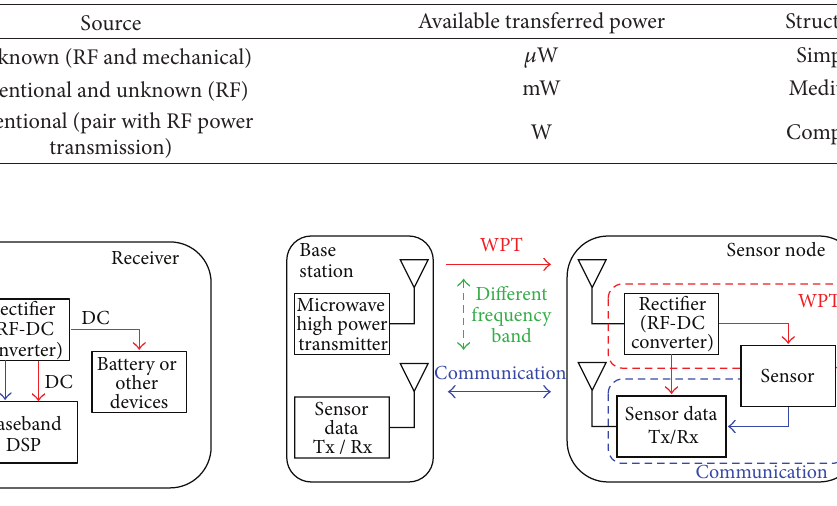
Table 2: WPT classifications by power level.